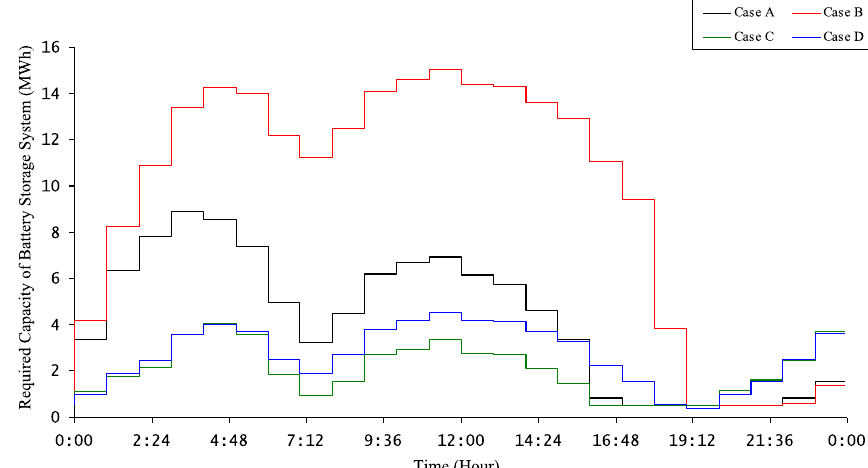
Fig. 11 Required capacities of battery storage system under four